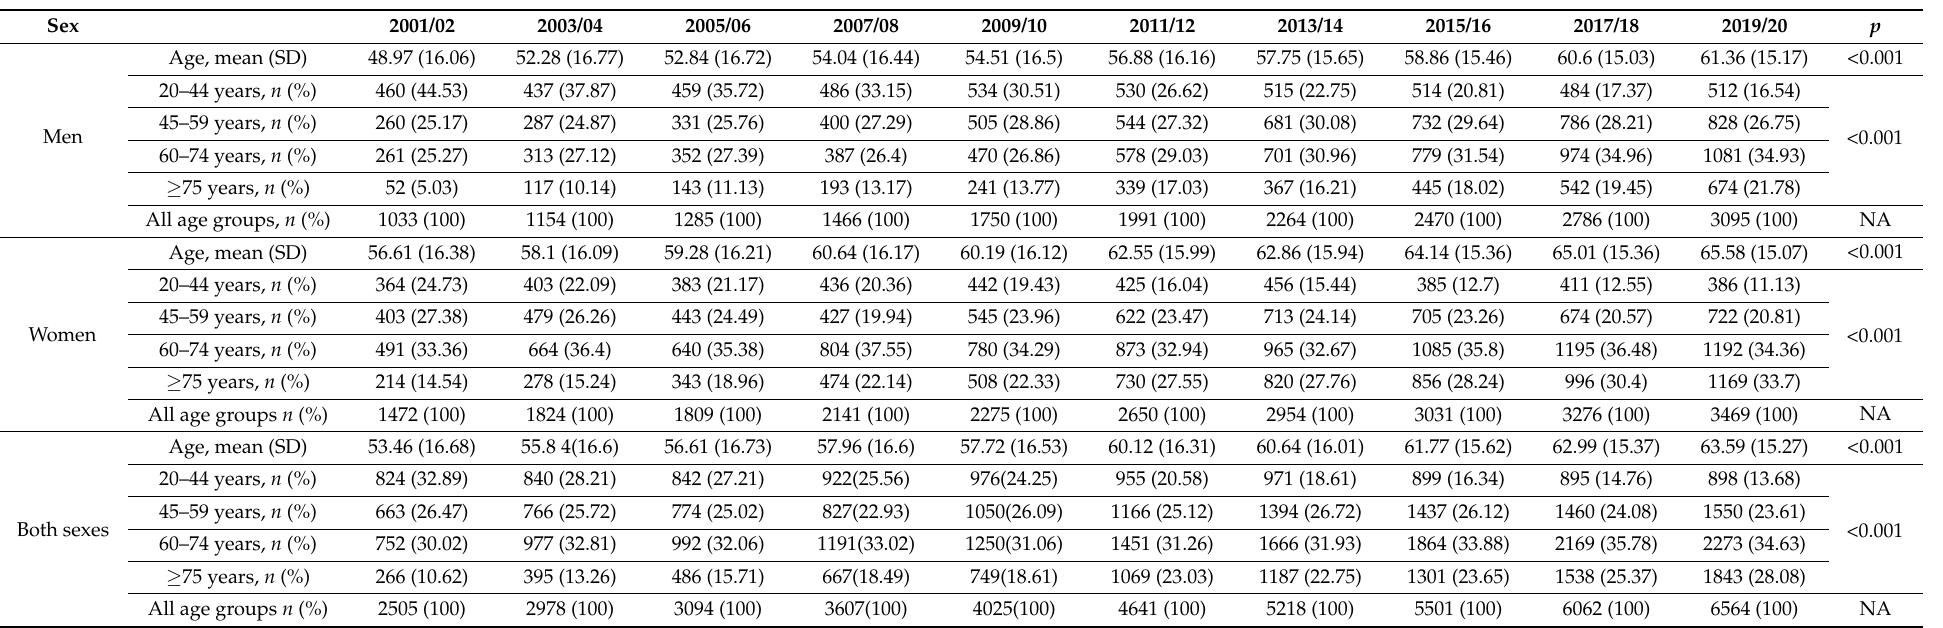
Table 1. Number of hospitalizations of adults with sarcoidosis in Spain from 2001 to 2020, according to sex and